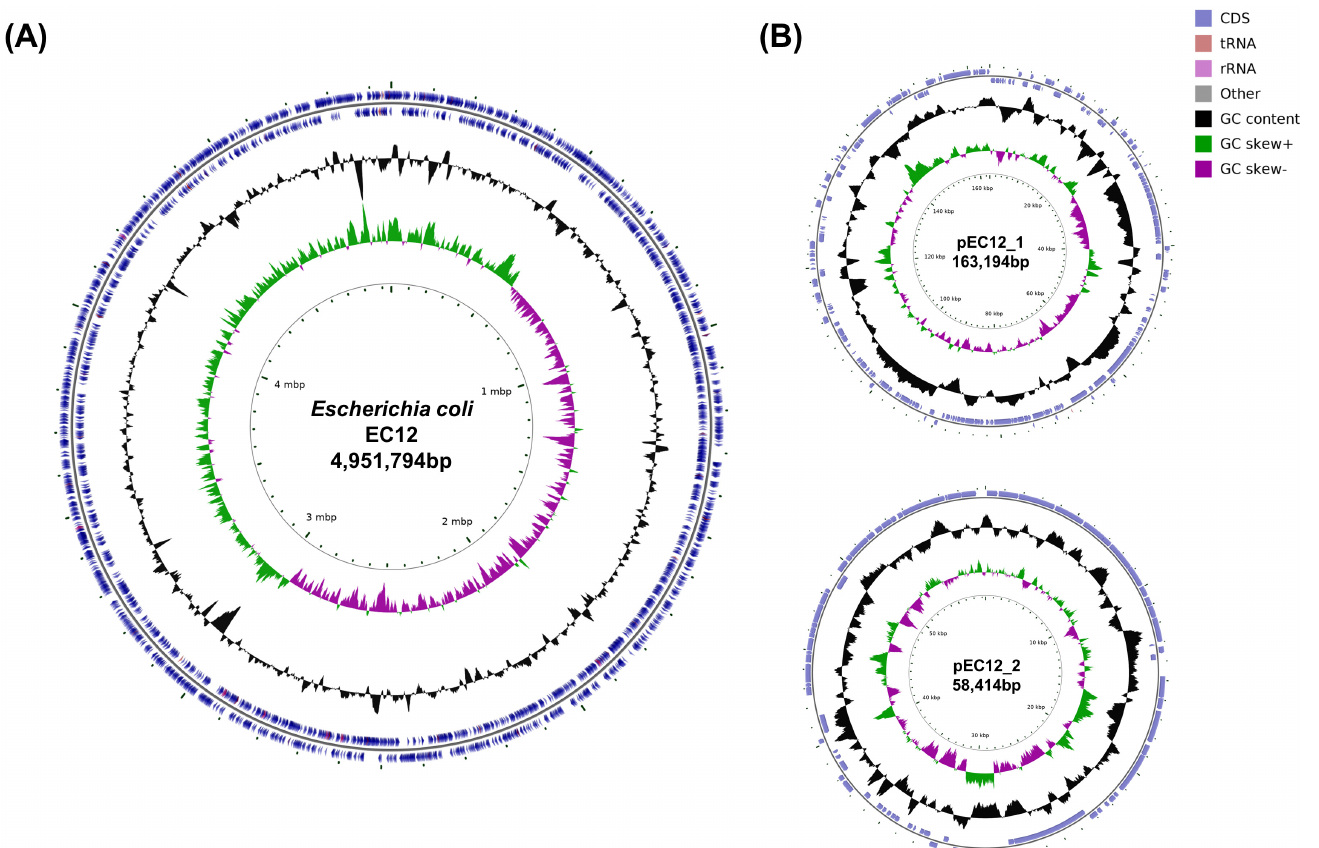
Figure 1. Circular maps of the chromosome ( A ) and two plasmids ( B ) of strain EC12. From the outer circle moving inward, circles 1 and 2 represent protein-coding genes (blue), tRNA genes (reddish brown), and rRNA genes (light purple) on the positive and negative strands; circle 3 shows the GC content (black); circle 4 shows the GC skew (positive GC skew, green; negative GC skew, purple); and circle 5 displays the genomic coordinates.